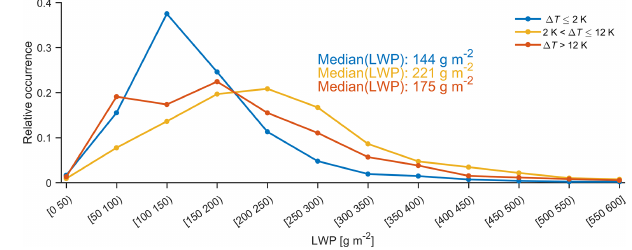
Figure 11. Relative occurrence of LWP for all columnar-ice- producing events. LWP: liquid water path. (cid:49)T = T column_top −